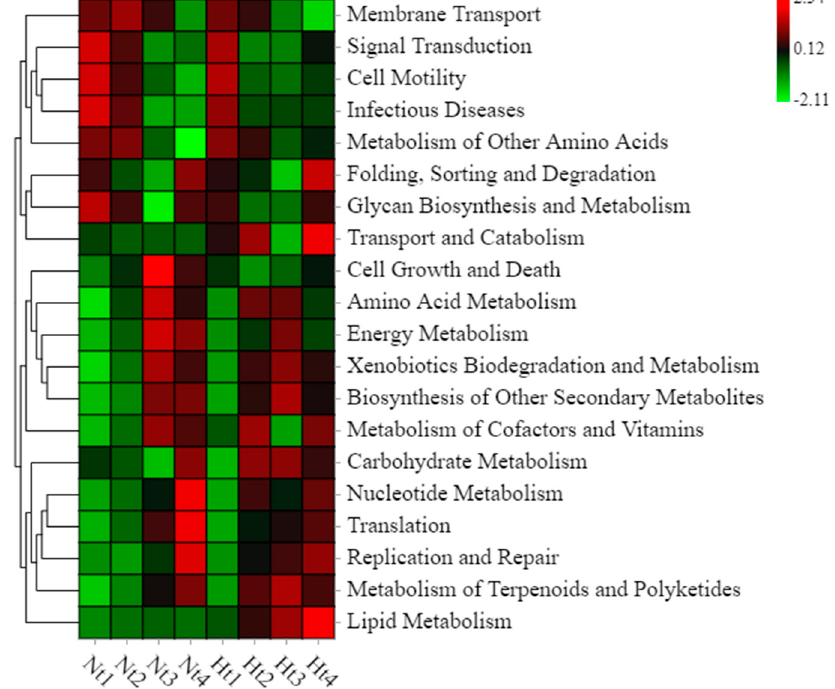
Figure 7. Functional prediction of epibacterial communities. KEGG pathway annotation of ASVs was inferred using Tax4Fun (version 1.0, Aßhauer et al., 2015 [30]). Nt: normal seawater temperature; Ht: 3 ◦ C higher temperature; 1, 2, 3, and 4 represent May, June, July, and August, respectively. The red to green color scale represents the relative abundance of metabolic functions in the epimi- crobiome.